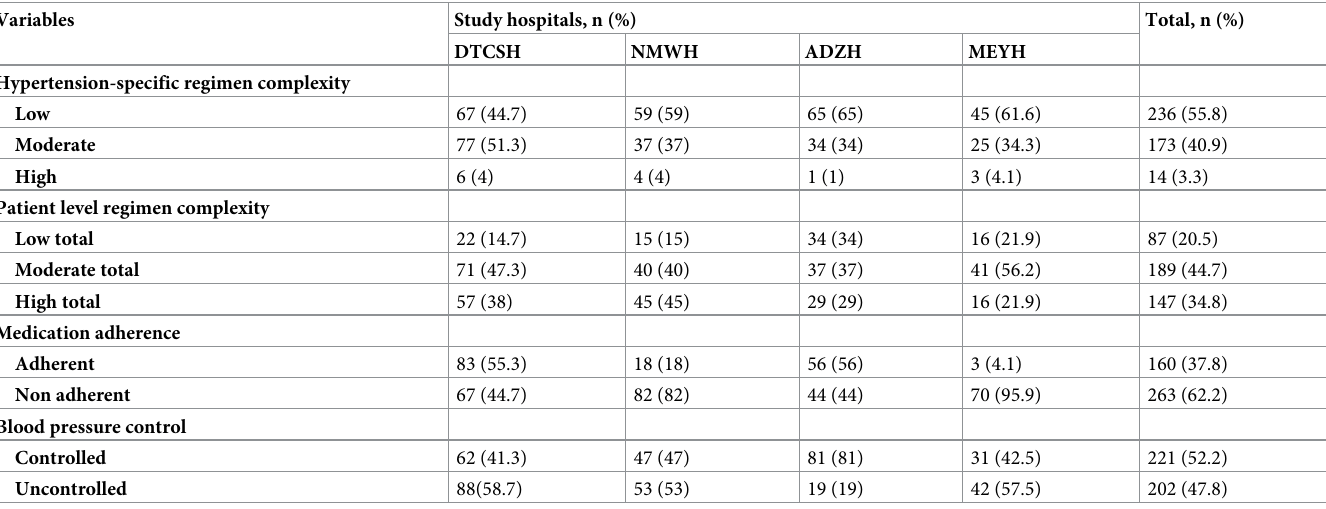
Table 2. Percentage distribution of regimen complexity, adherence and blood pressure control (N =